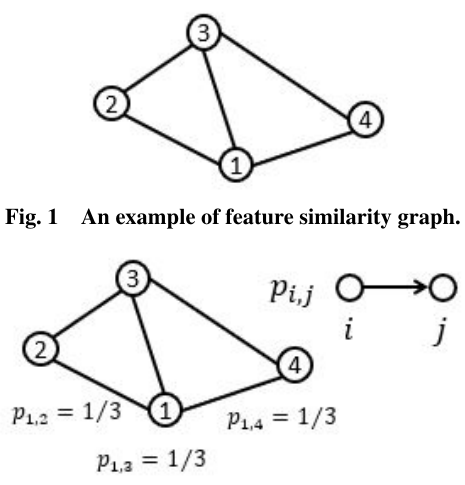
Fig. 2 Transition probabilities on the